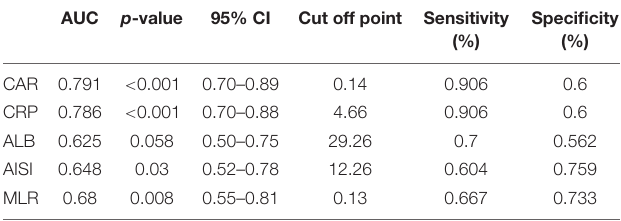
TABLE 2 | The ROC curves and prognostic accuracy of the inflammation-based